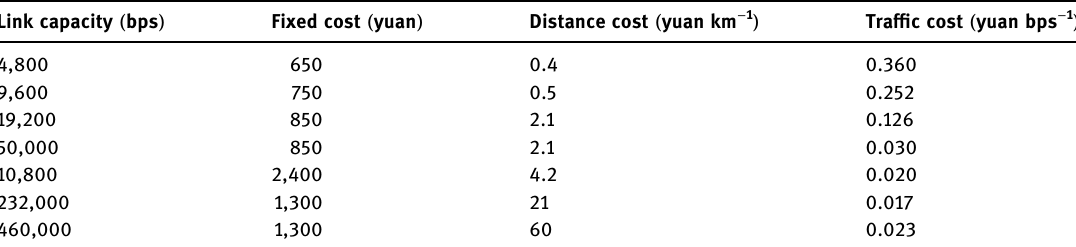
Table 1: Link capacity and its cost